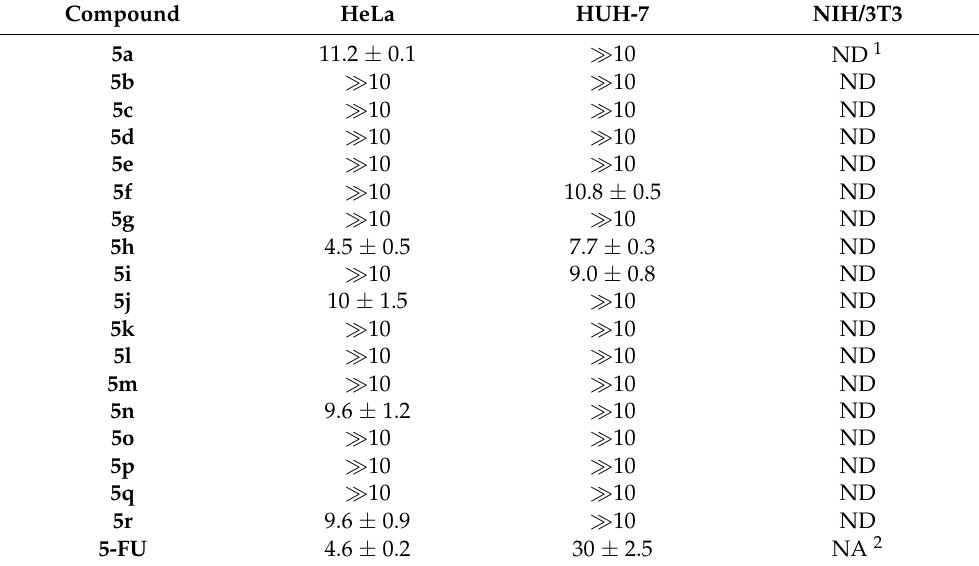
Table 3. IC 50 values ( µ M) for the new 1,2,3-triazole-uracil scaffolds 5a – r against the treatment of HeLa and HUH-7 tumor cells and NIH/3T3 normal cells after 72 h. Compound HeLa HUH-7